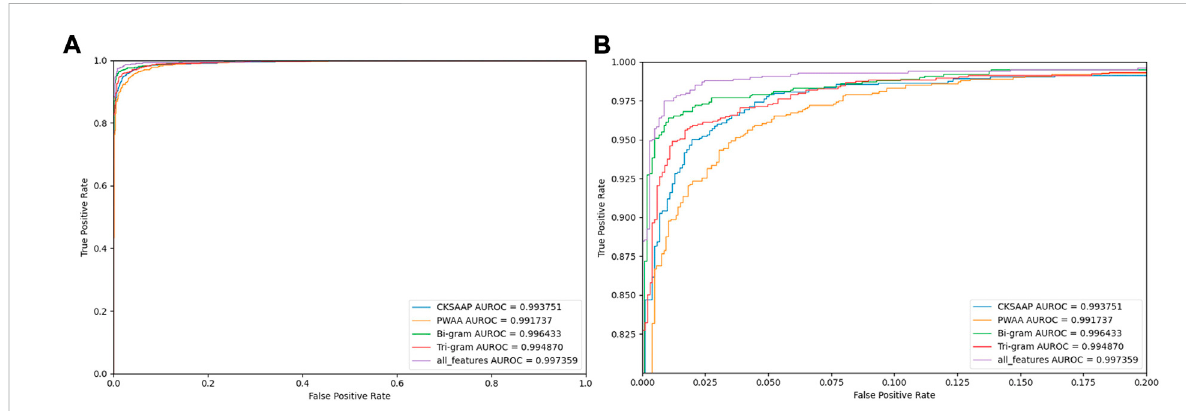
FIGURE 7 Comparing ROC curves with different feature codes. Note: (B) is a partially enlarged view of (A) .